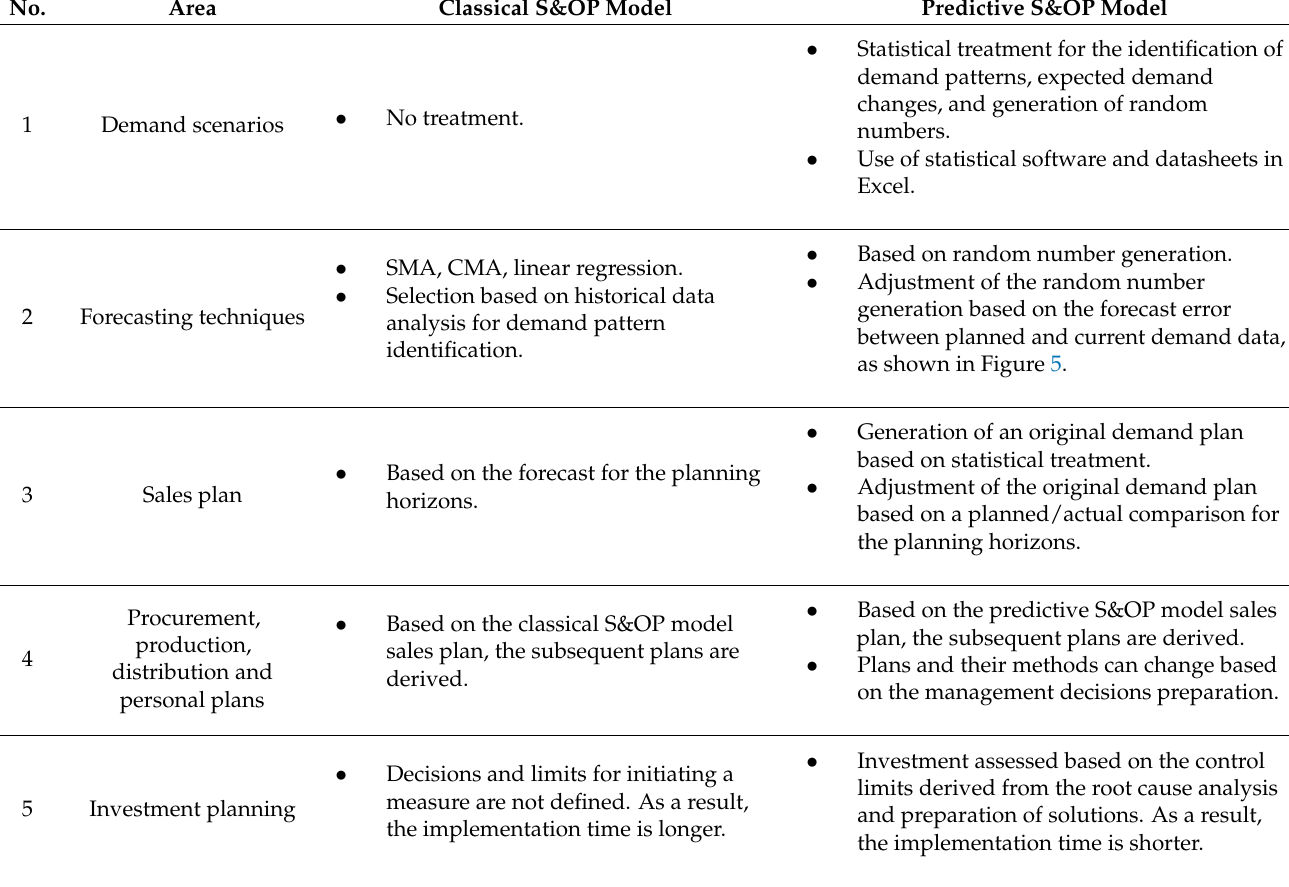
Table 7. Simulation logic differences between models (own